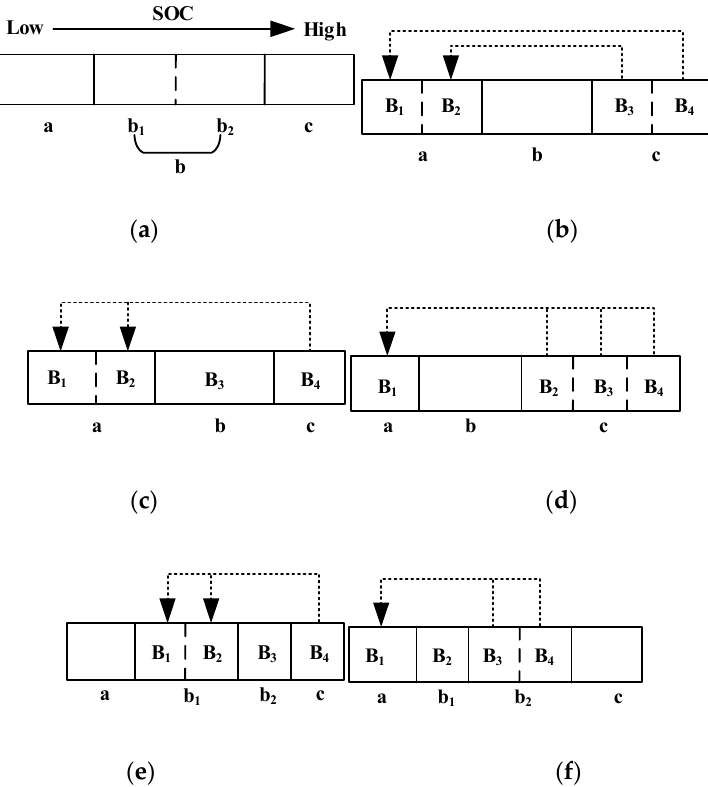
Figure 7. Flowchart of the proposed equalization algorithm.